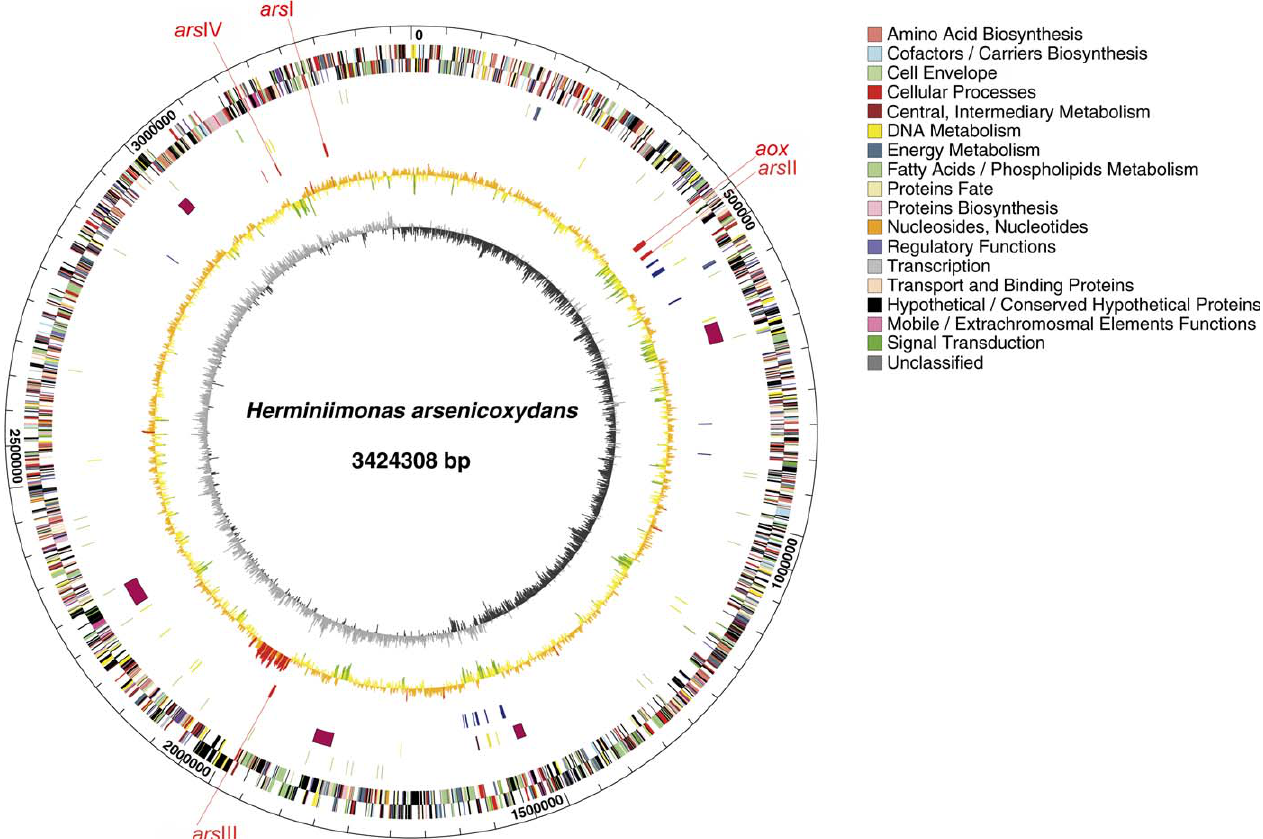
Figure 1. Circular Representation of H. arsenicoxydans Genome Circles display (from the outside inward): (rings 1 and 2) predicted CDSs transcribed in a clockwise/counterclockwise direction, (ring 3) tRNA (green) and rRNA (violetblue), (ring 4) ISs (yellow) and prophagic regions (violetbrown), (ring 5) clusters of genes involved in arsenic (red; numbered as shown in Figure 4)/metal resistance (dark blue), (ring 6) GC deviation (GC window (cid:2) average GC of genome, using a 1kb window); (7) GC skew (using a 1kb window). The high GC-rich island described in Figure 2 is shown in red.